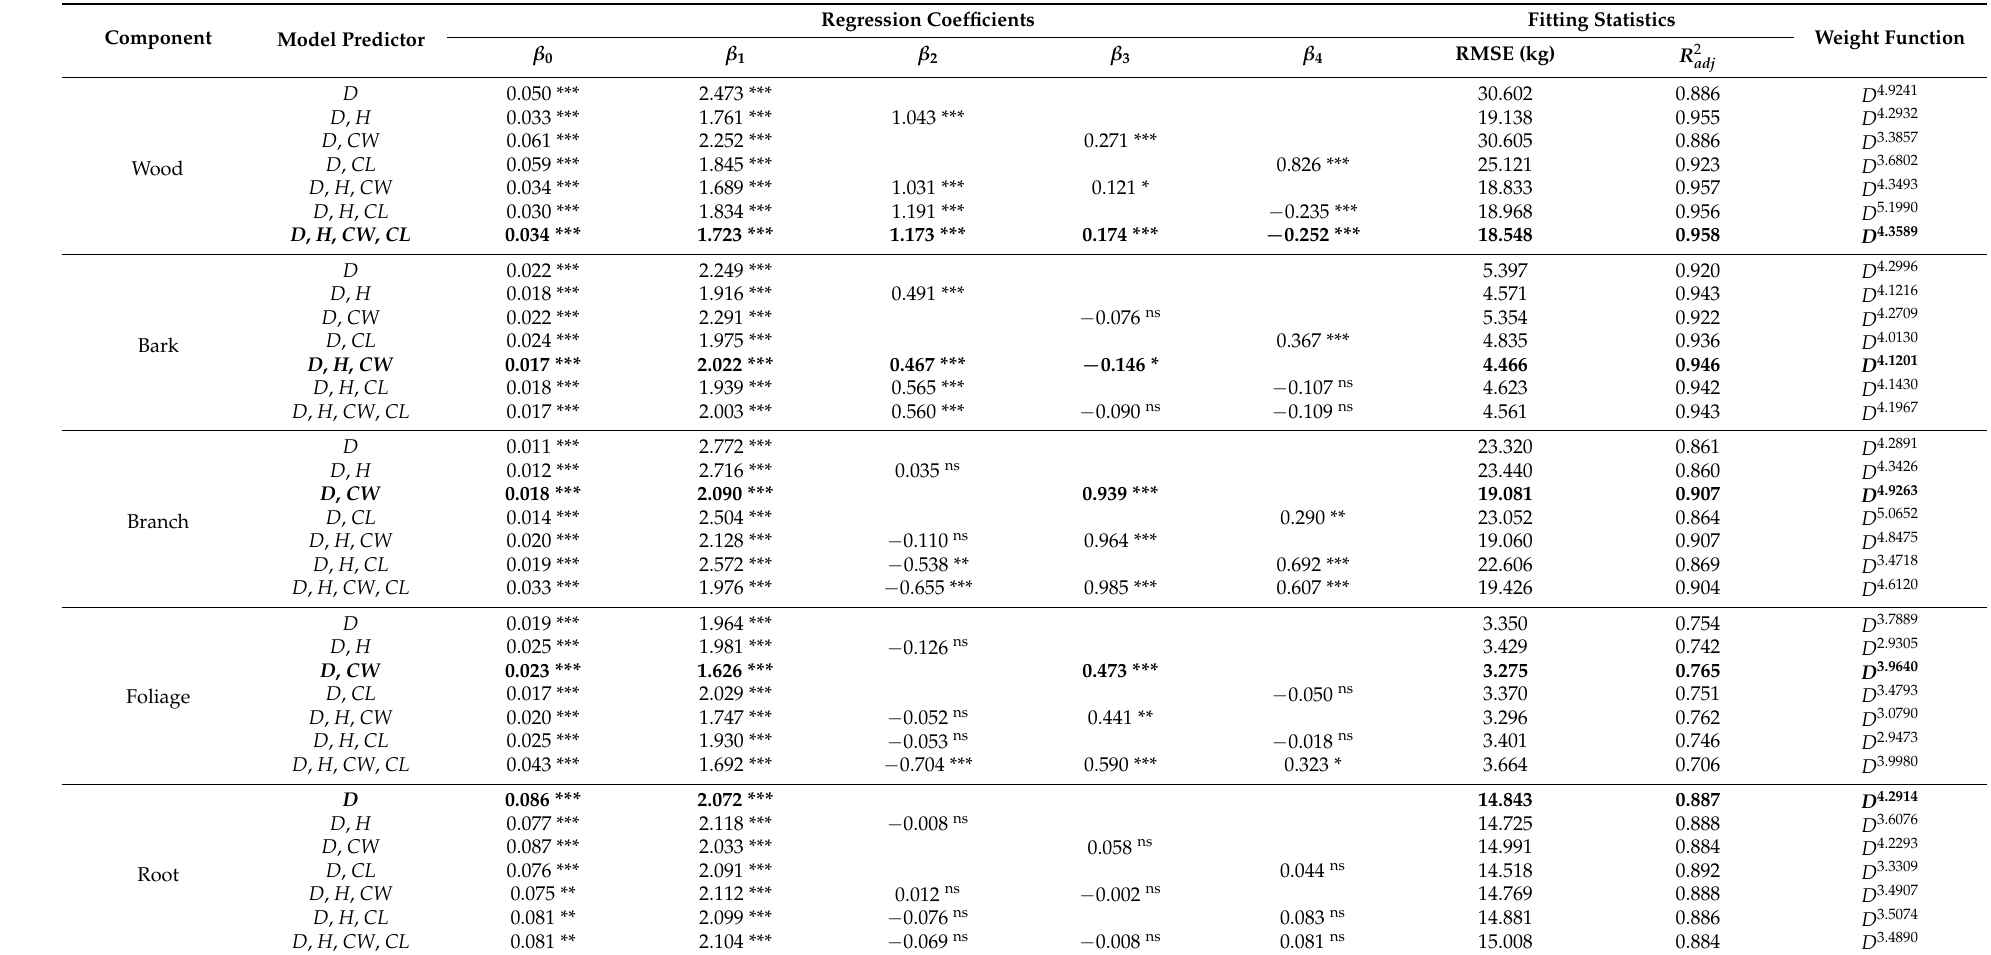
Table 3. Regression coefficients and statistics of the aboveground additive systems and root biomass equations with a specific weighting